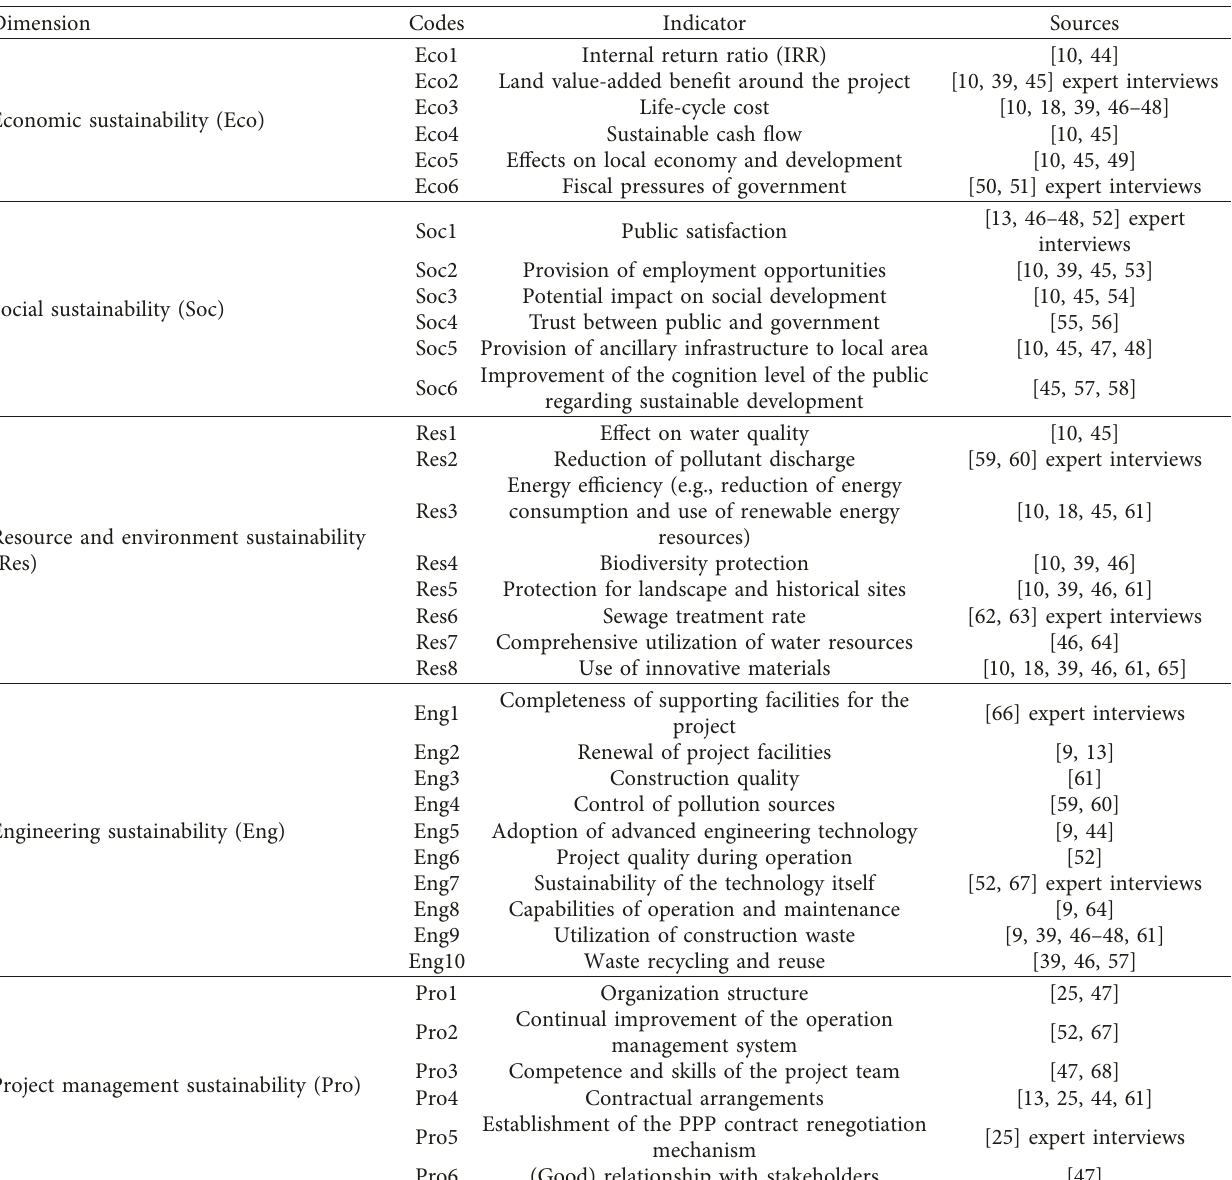
Table 1: Sustainable development